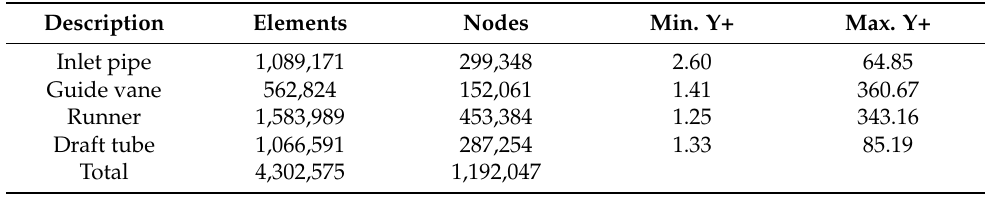
Table 3. Grid quality of the tubular turbine.